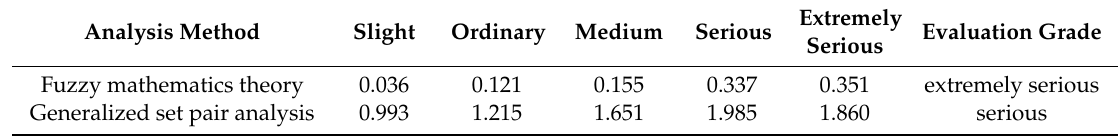
Table 4. Comparison of evaluation